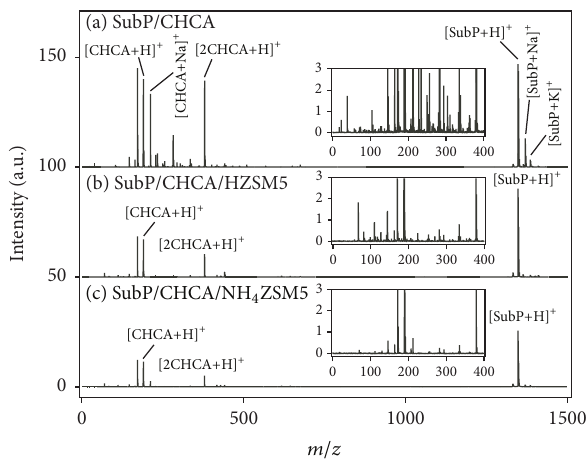
Figure 1: Mass spectra of SubP measured with (a) CHCA only, (b) CHCA/HZSM5, and (c) CHCA/NH 4 ZSM5. Insets are magnifica- tions of the mass region less than 400